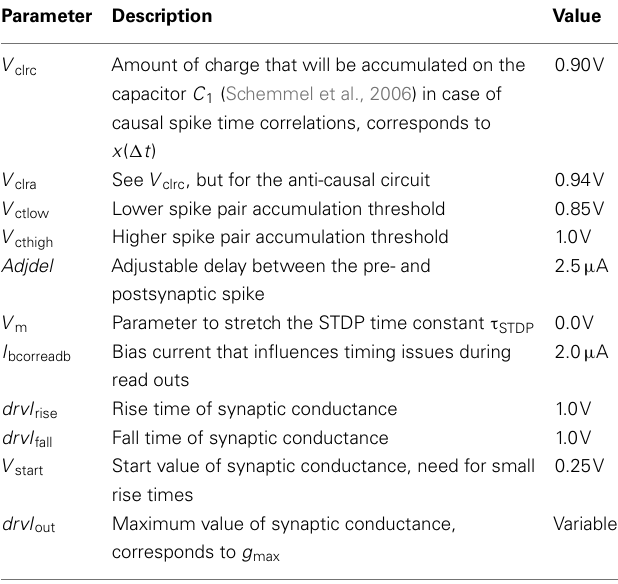
Table 6 |Applied hardware